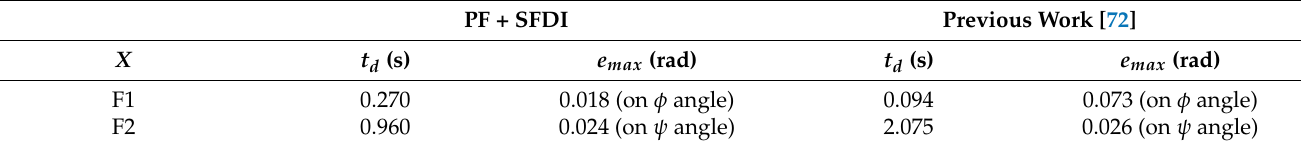
Table 8. Comparison between duplex architectures. PF +